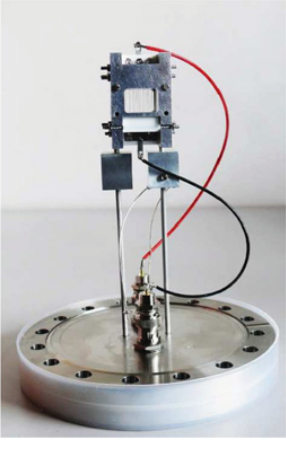
Figure 4. Bradbury Nielsen gate consisting of two insulated wire grids being chargeable with ± 500V each. For adjusting the grid input resistance to the 50 (cid:9) cable between electronics and BN gate, the grids are grounded by a serial RC element with R = 50 (cid:9) and C = 100nF (not shown).